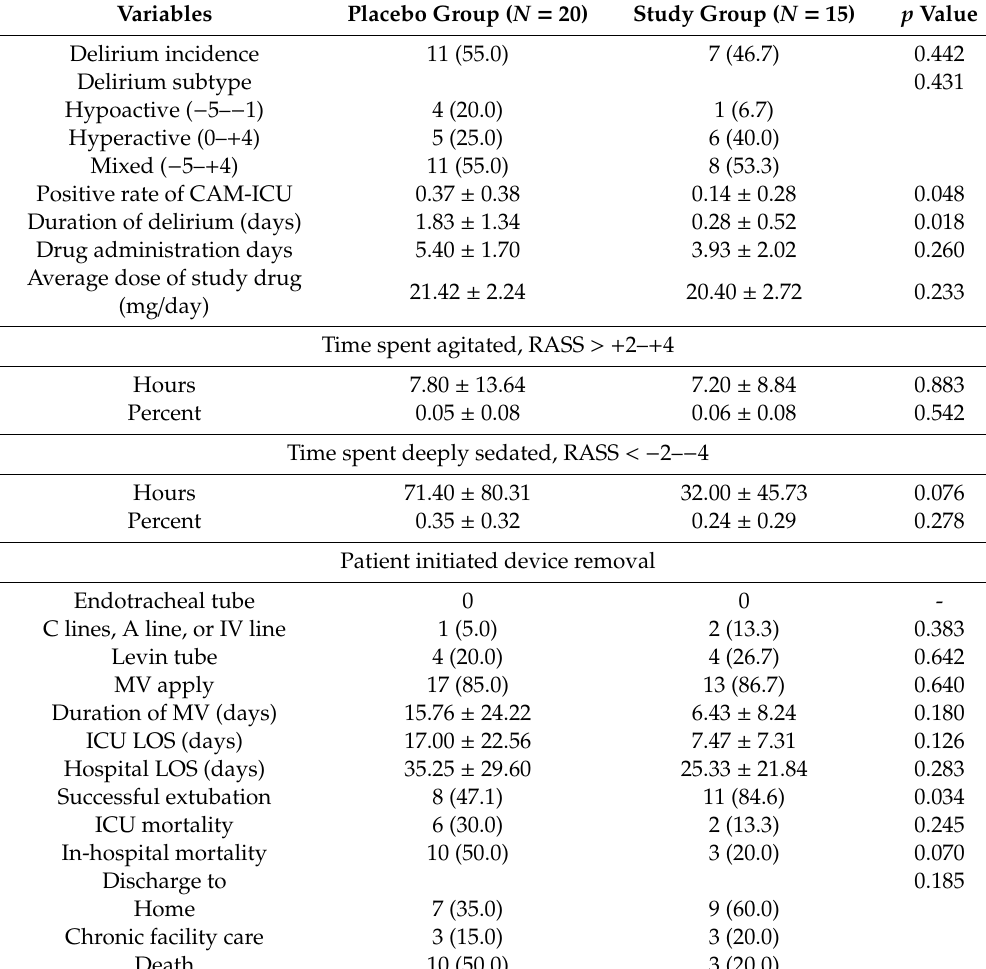
Table 2. Clinical outcomes related to ICU delirium.